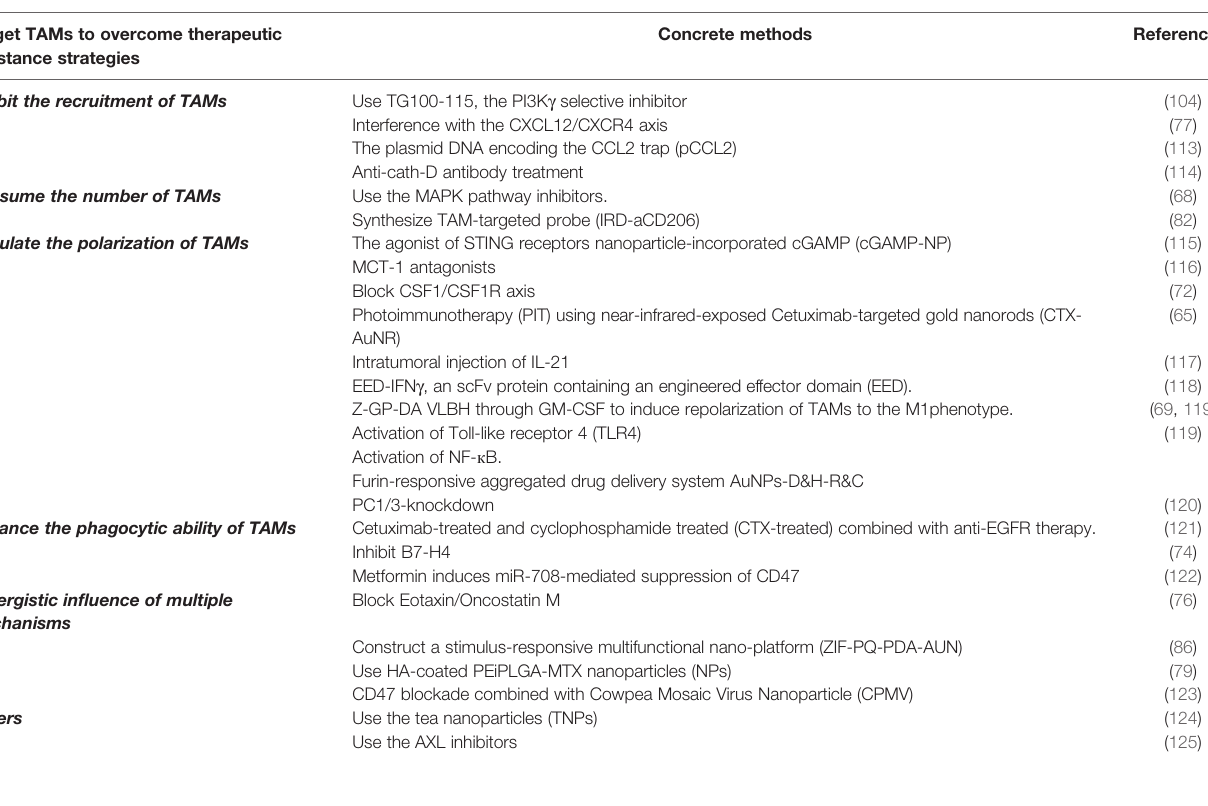
TABLE 2 | Targeted TAMs to overcome therapeutic resistance